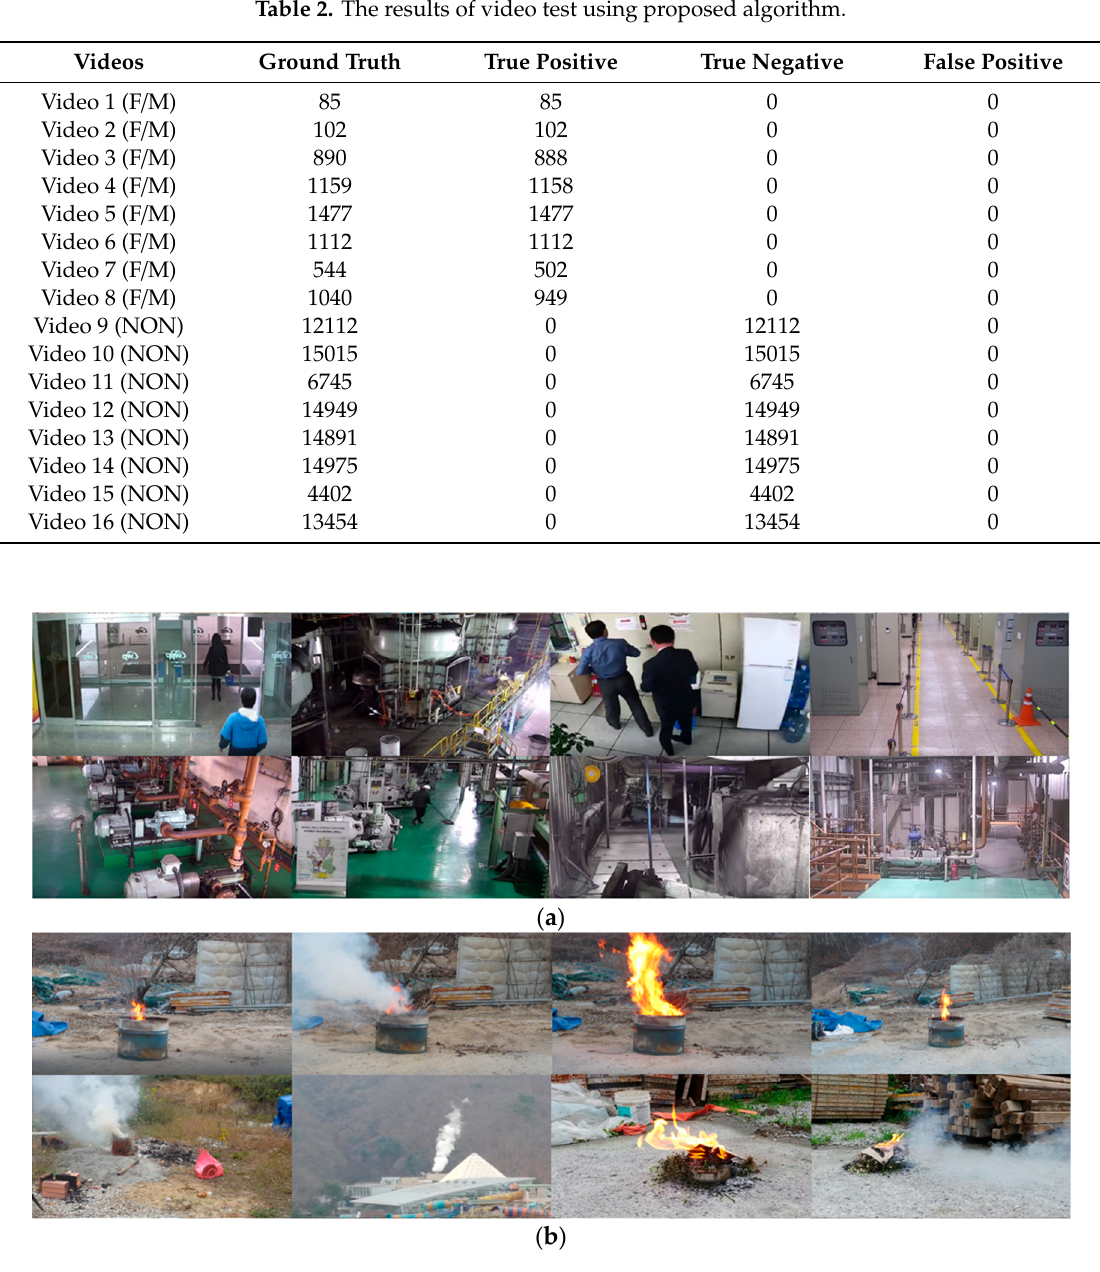
Figure 9. Experimental videos for proposed algorithm test: ( a ) factory and office videos and ( b ) fire and smoke videos.